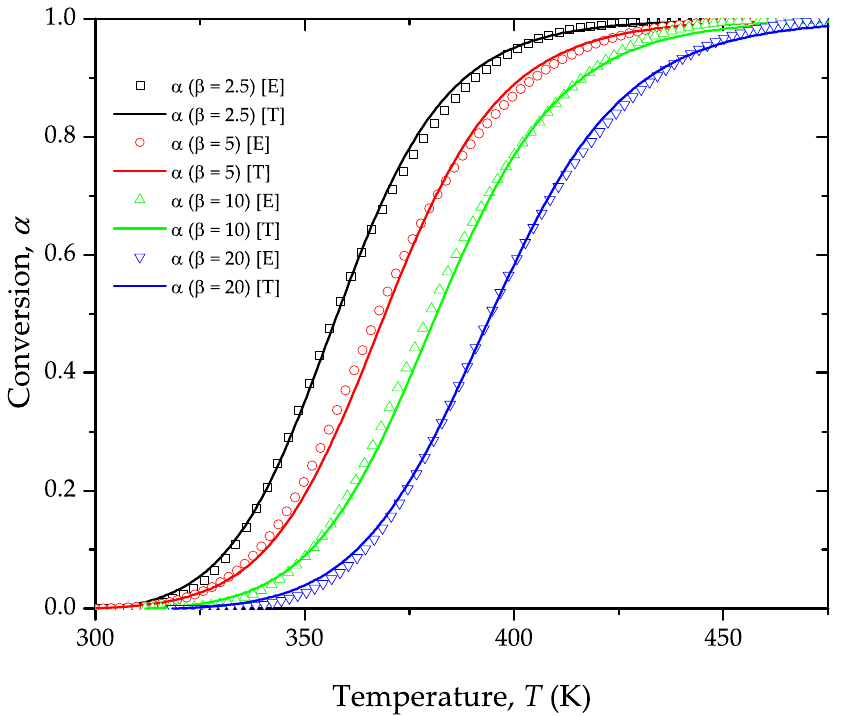
Figure 11. Comparison of conversion, 𝛼 , corresponding to the crosslinking of a partially bio ‐ based epoxy resin for different heating rates. Symbols represent experimental values [E] and lines represent theoretical [T] values.